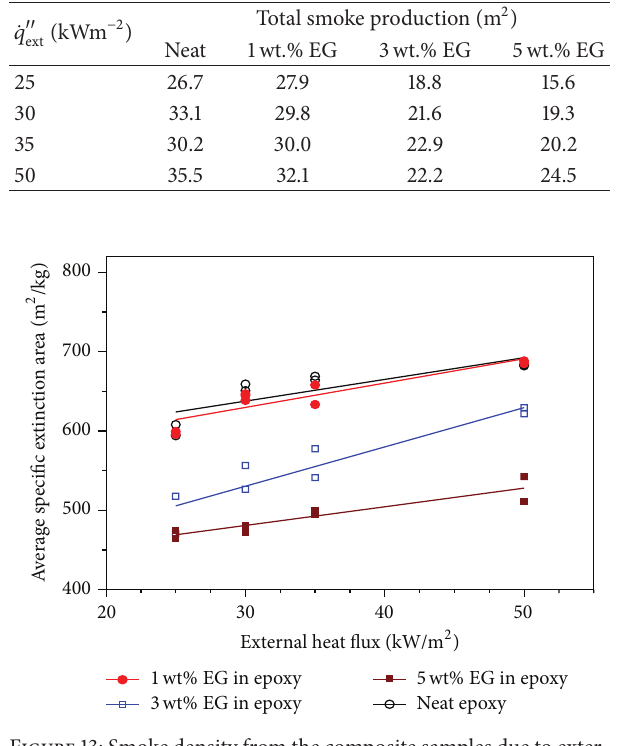
Figure 13: Smoke density from the composite samples due to exter- nal heat fluxes.